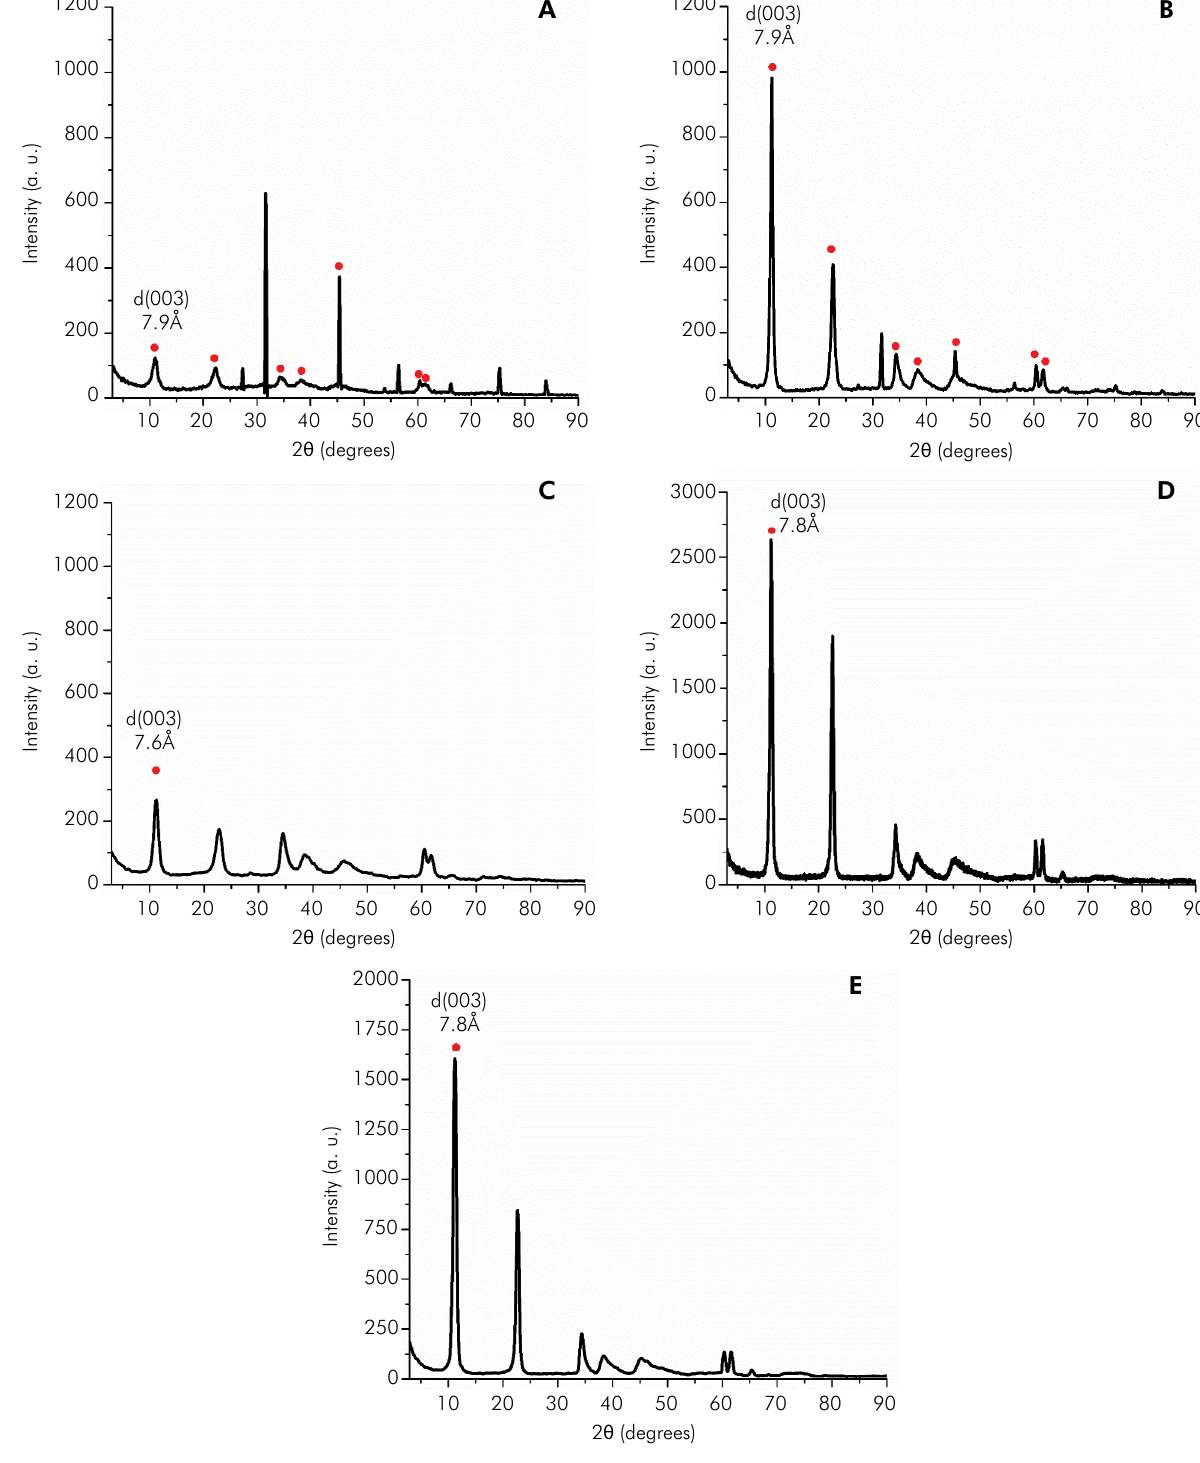
Figure 1. Diffractograms of precursors C-LDH (A) and N-LDH (B). (C), (D), and € illustrate the diffractograms of F-LDH synthesis at 25°C for 2 h. Fluoride product (F-LDH/1) synthesis from C-LDH precursor (C). Fluoride product (F-LDH/5) synthesis from N-LDH colloidal suspension (D). Fluorinated product (F-LDH/9) synthesis from N-LDH powder (E). Note, the baseline spacing d (003) value was 7.9 Å for both precursors. Fluoride products showed a reduction (7.6 Å and 7.8 Å). The crystallographic pattern similarity in all materials was